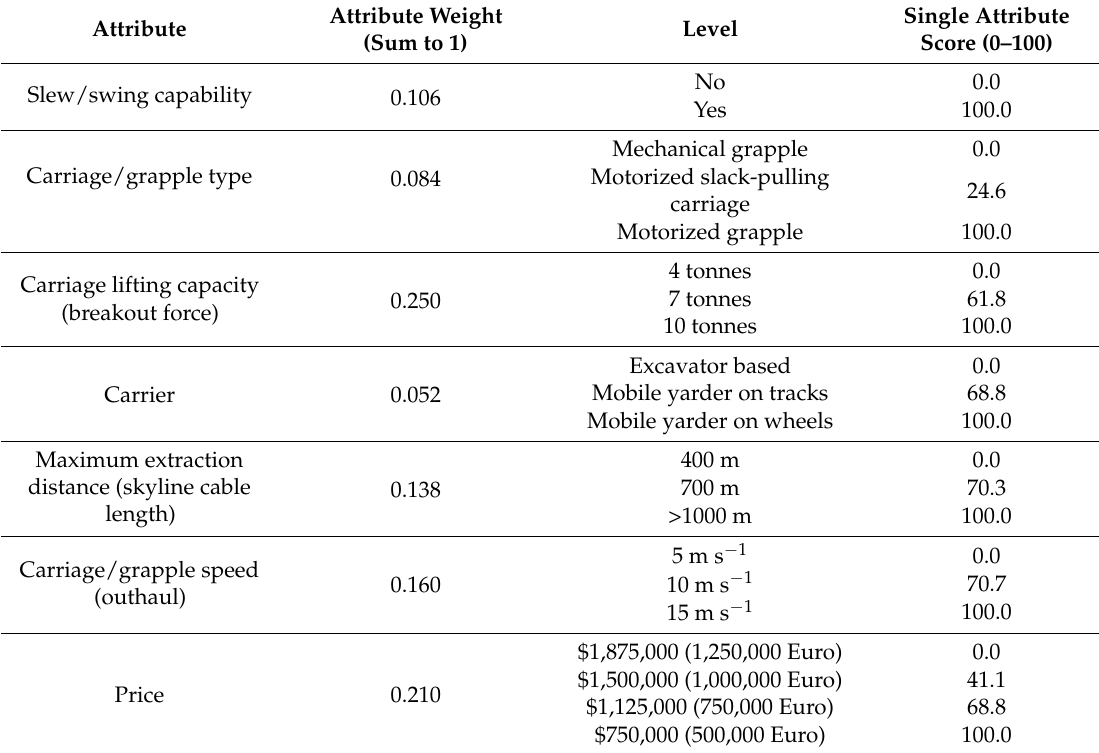
Table 4. Normalized attribute weights and single attribute scores for cable yarder